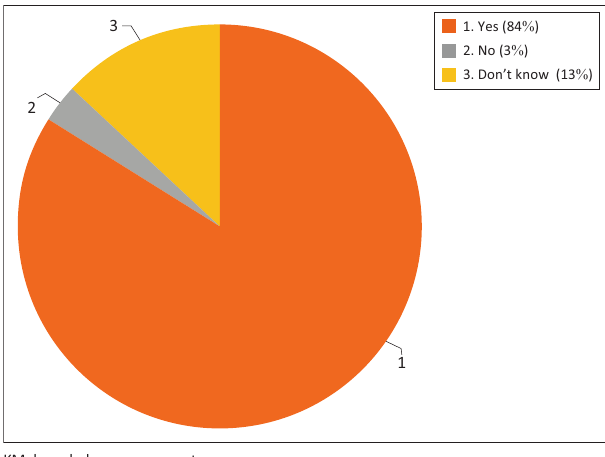
FIGURE 3: Benefits to employees from a knowledge management initiative ( N = 61).